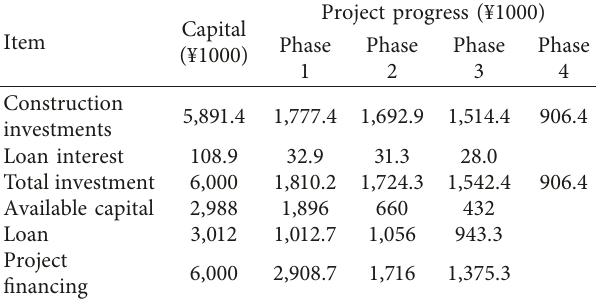
Table 4: Results of economic merits by shortening construction